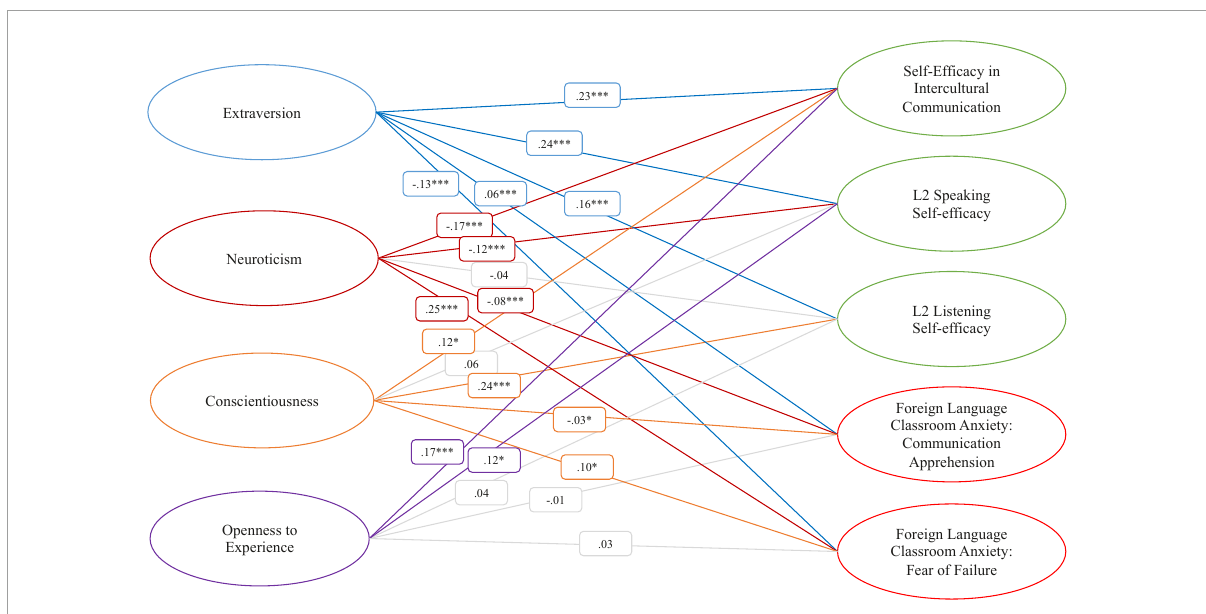
FIGURE1 Visual representation of the structural equation model estimating the relations between the Revised Big Five factors, L2 self-efficacy domains, and FLCA factors. Model fit indices, Robust χ 2 (1,493) = 4906.337; RMSEA (95% CI) = 0.042 (0.040–0.043); CFI/TLI = 0.925/0.920. Residuals for one SEIC item (SEIC 1) and Conscientiousness and one item for SEIC Extraversion (SEIC 8) were allowed to correlate after examination of modification indices. ∗ p < 0.05, ∗∗∗ p <